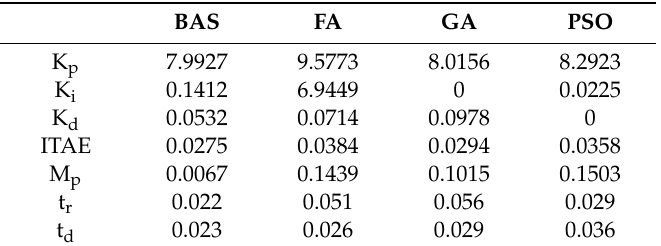
Table 3. PID parameters and performances of the control